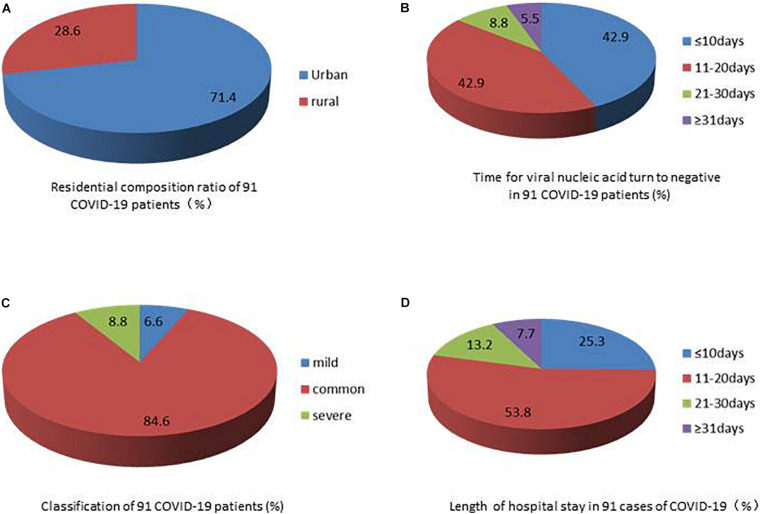
(A) Residential composition ration of 91 COVID-19 patients (%). (B) Time for viral nucleic acid turn to negative in 91 COVID-19 patients (%). (C) Classification of 91 COVID-19 patients (%).(D) Length of hospital stay in 91 cases of COVID-19 (%).